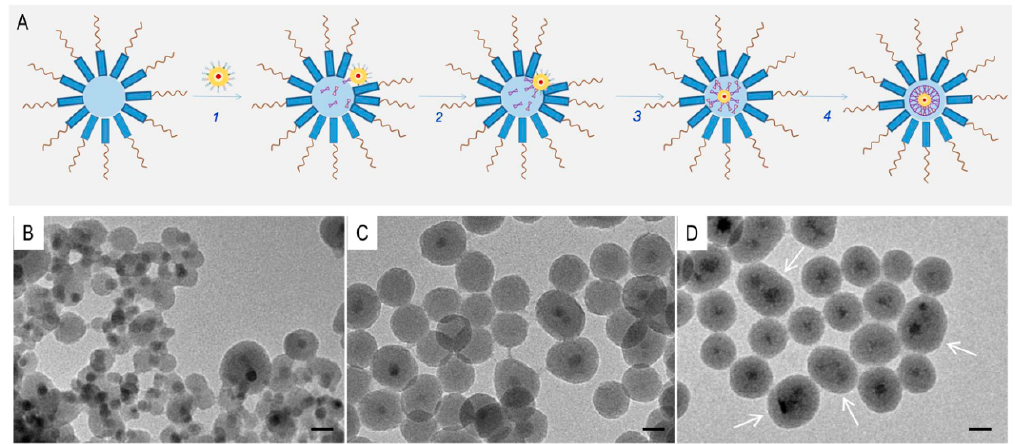
Figure 2. ( A ) Scheme of the water-in-oil microemulsion approach for silica shell growth: addition of the organic-capped giant quantum dots (QDs) to the water-in-oil microemulsion (step 1), displacement of the native ligands at the QD surface by surfactant molecules and hydrolyzed TEOS (step 2), inclusion of the surface modified QDs inside the water pool of the inverse micelle (step 3) and formation of the siloxane network around the QDs (step 4). TEM micrographs (Scale bar 50 nm) of the silica nanostructures prepared using native “giant” quantum dots (GQDs) ( B ) and oleyl amine-treated GQDs at increasing volume of GQDs: 30 µ L ( C ) and 80 µ L ( D ). The reaction mixture consists of 350 µ L Igepal CO-520, 200 µ L NH 4 OH, 50 µ L TEOS and 30 µ L APTS. The reaction is let to proceed overnight at 28 ◦ C temperature. Arrow used in panel D to highlight the elongated multicore structures (32% yield).